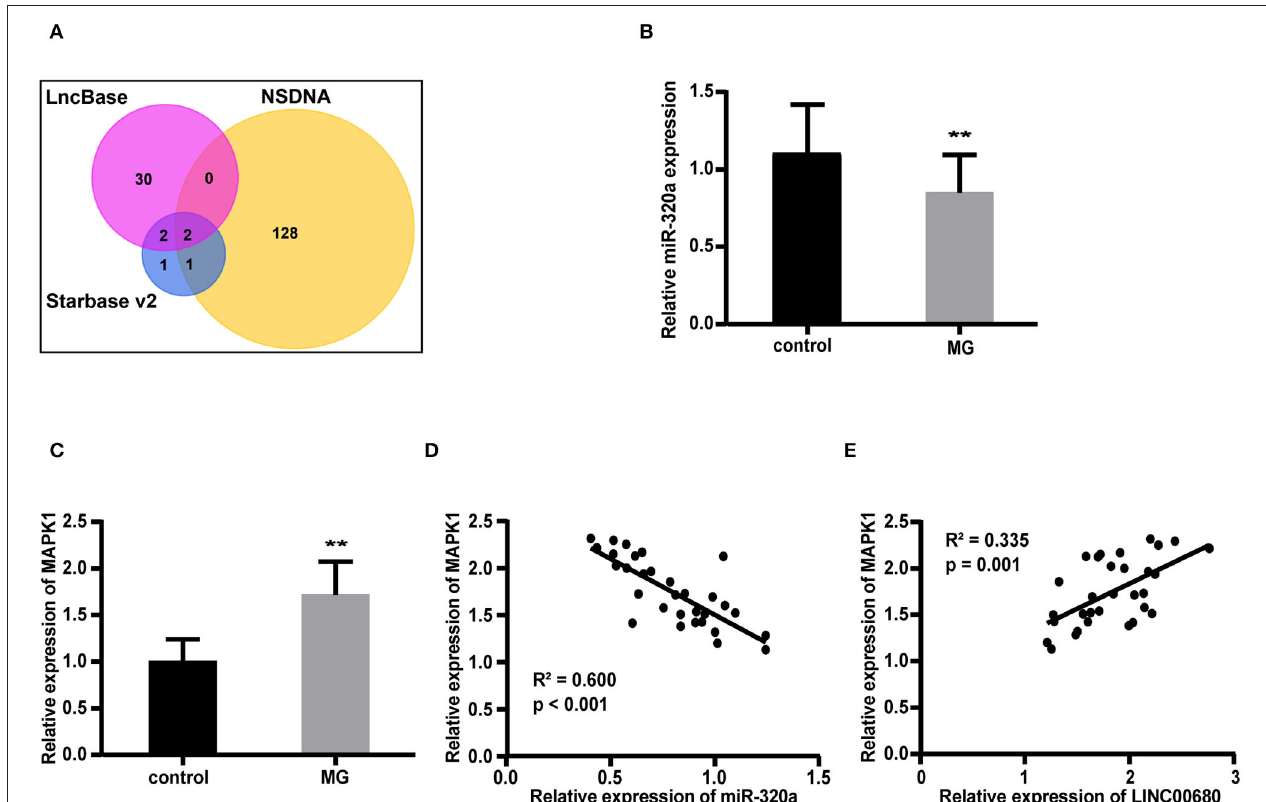
FIGURE 2 | Construction of a LINC00680-miR-320a-mitogen-activated protein kinase 1 (MAPK1) interaction network for MG. (A) Venn diagram showing the overlapping target genes of LINC00680 associated with MG that was predicted using the Starbase v2.0, DIANA-LncBase, and the Nervous System Disease NcRNAome Atlas (NSDNA) databases (B,C) miR-320a expression and MAPK1 messenger RNA (mRNA) expression were examined in 31 patients with MG and 31 control subjects by real-time PCR (D) Correlation analyses between MAPK1 messenger RNA (mRNA) expression and miR-320a expression in patients with MG (E) Correlation analyses between MAPK1 mRNA expression and LINC00680 expression in patients with MG (** p <